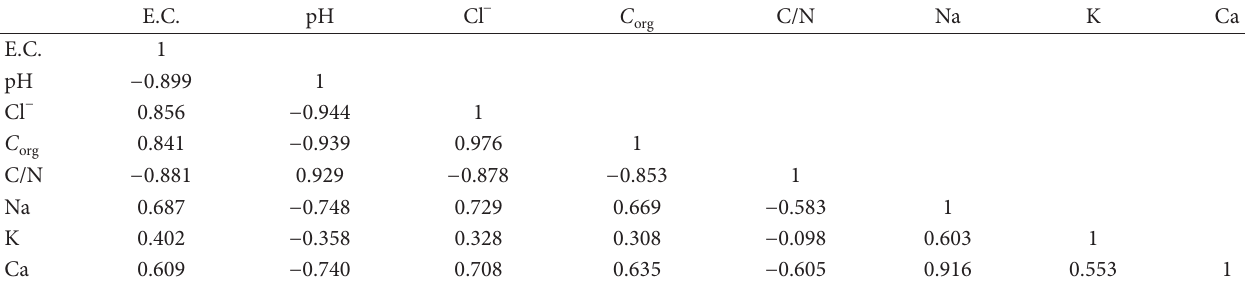
T 3: Correlation coefficient of physico-chemical parameters of soil as in�uenced by jute mill solid waste. E.C.